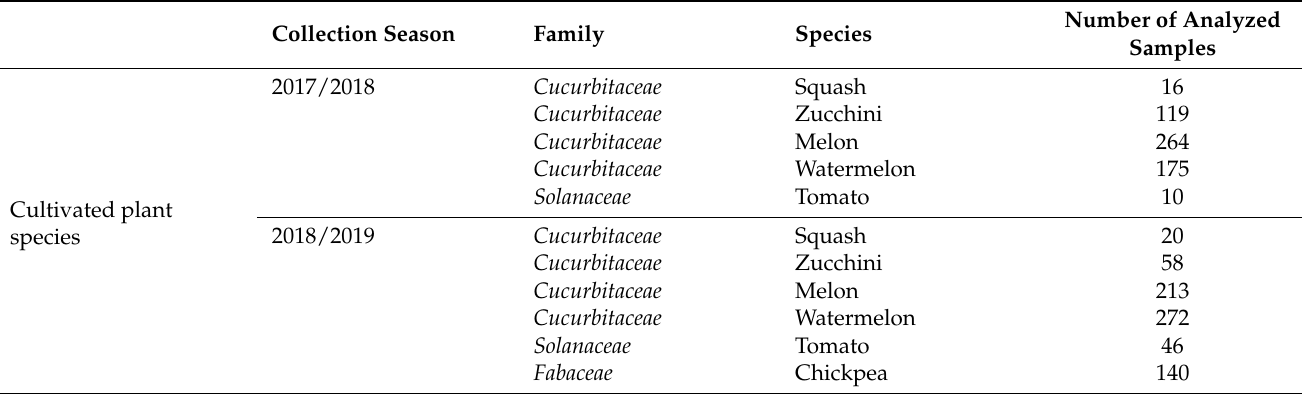
Table 1. Description of the 1333 samples collected during two growing seasons from different crop species.